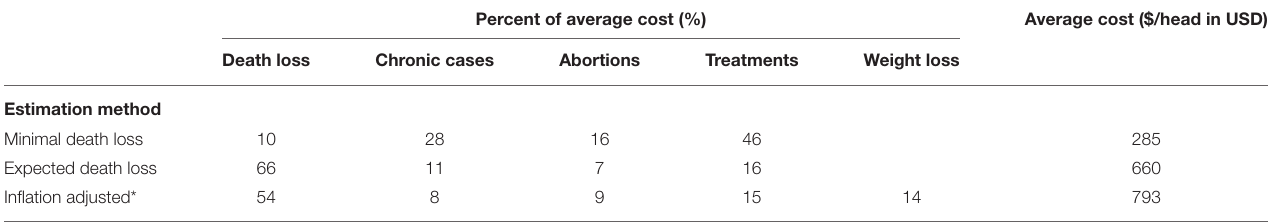
TABLE 2 | Estimated average costs of anaplasmosis by estimation method and production